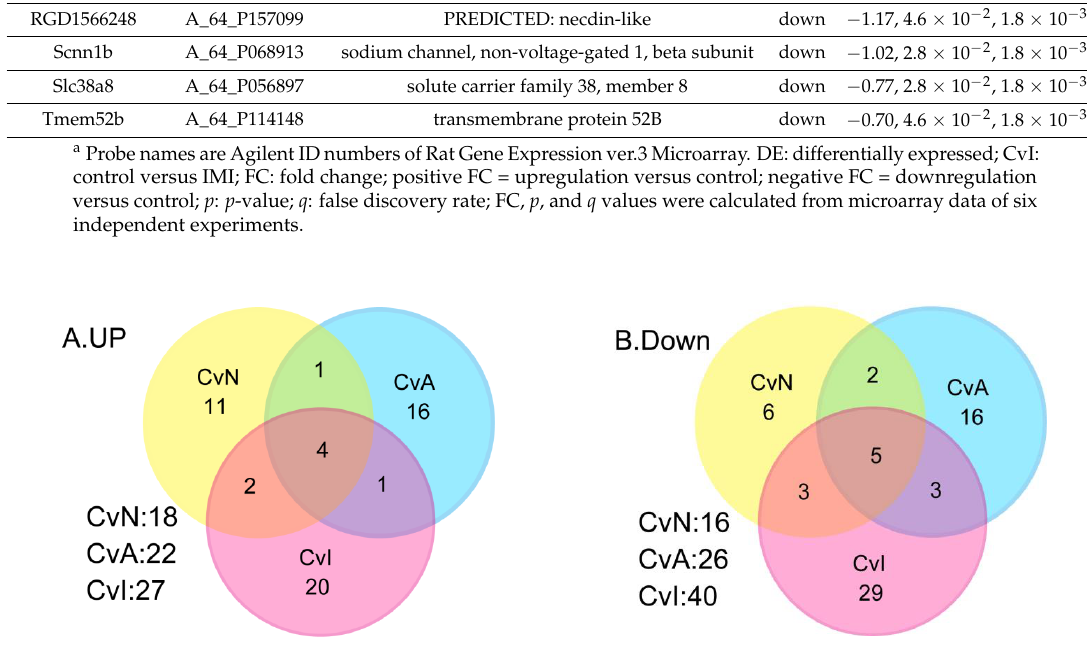
Figure 3. Overviews of gene expression changes in cerebellar cultures exposed to nicotine (NIC), acetamiprid (ACE), and imidacloprid (IMI) for 14days (16DIV). In altered transcriptomes of control versus NIC (CvN), control versus ACE (CvA), and control versus IMI (CvI), 34, 48, and 67 genes, respectively were filtered at cutoff threshold values of p < 0.05, q < 0.05, and fold change (FC) ≥ 1.5. Venn diagrams show numbers of genes upregulated ( A ) and downregulated ( B ) after the three treatments versus control.